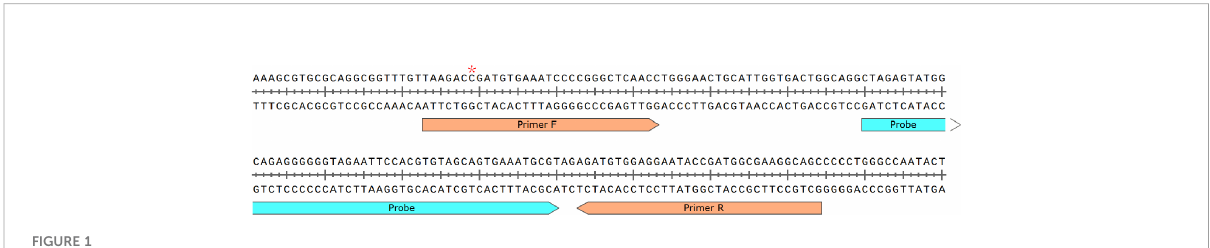
FIGURE 1 Primer and probe sequences used in RAA detection. * denotes the site with multiple subtypes between BCC species, Burkholderia cepacia is C, Burkholderia multivorans is A or C, Burkholderia vietnamiensis is C, and Burkholderia ambifaria is